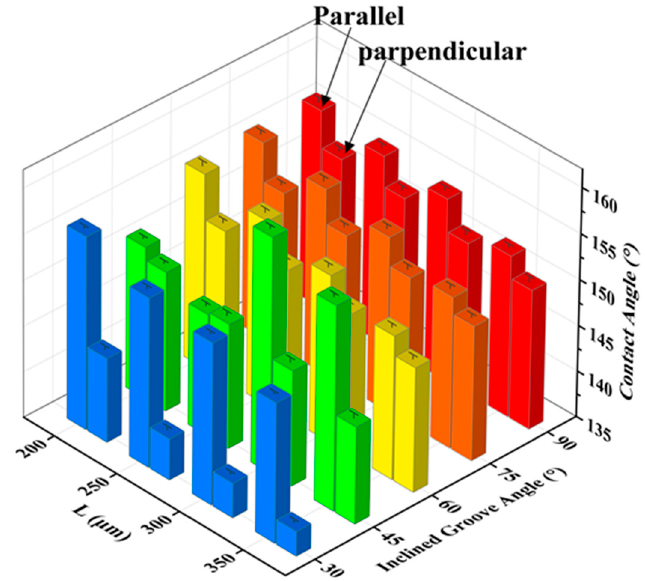
Figure 7. The change of contact angles in directions parallel and perpendicular to inclined groove surfaces with different inclination angles with L